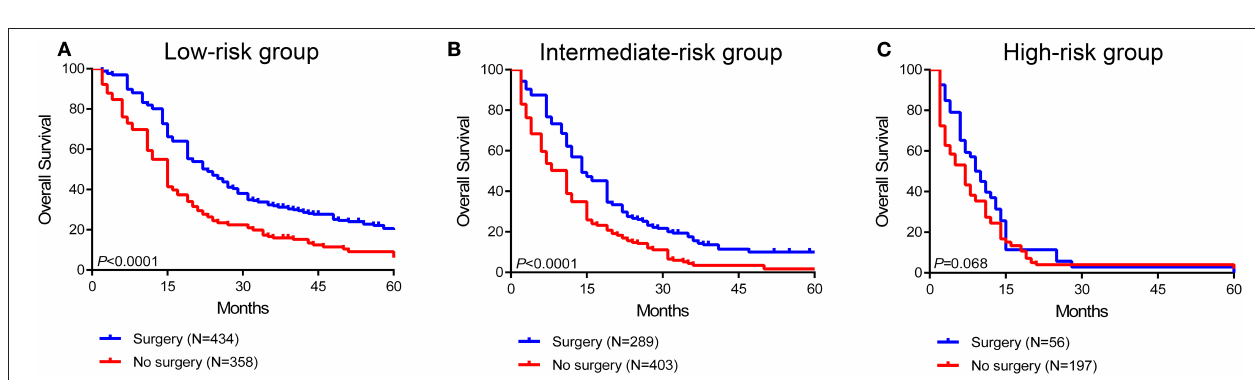
with synchronous metastasis, especially in patients with the molecular subtype of HR-positive/HER2-negative and HER2-